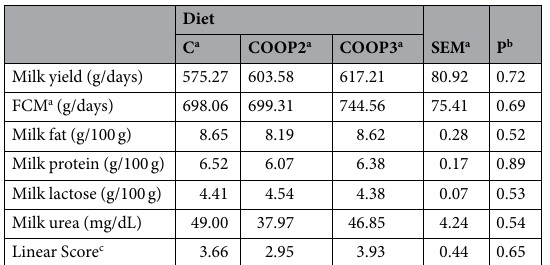
Table 3. Effect of olive oil pomaces on milk yield and composition. a Acronyms used in this table: C (control diet), COOP2 (control diet added with olive oil pomace extracted with a two-phase procedure), COOP3 (control diet added with olive oil pomace extracted with a three-phase procedure), SEM (Standard Error Mean) and FCM (Fat-Corrected Milk). b Probability of significant effect due to experimental diets; means within a row with different letters differ (P < 0.05). c Linear score: log2 (Somatic cell